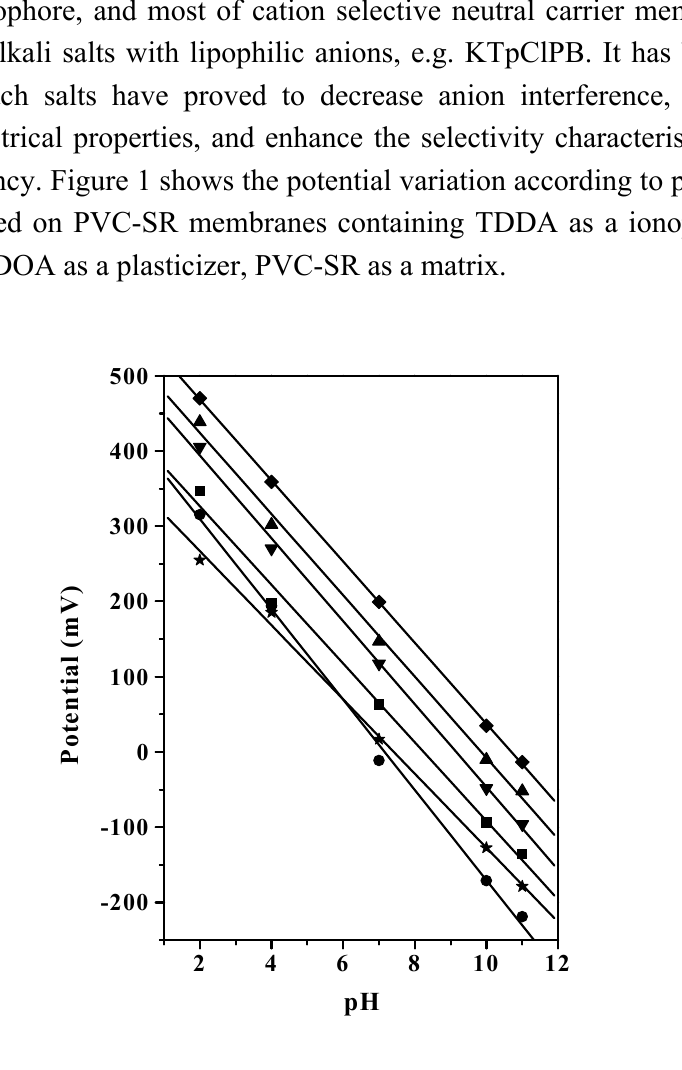
Figure 1 . Calibration curves for the PVC-SR membrane electrodes. ■ PVC ▲ 5.0 wt %